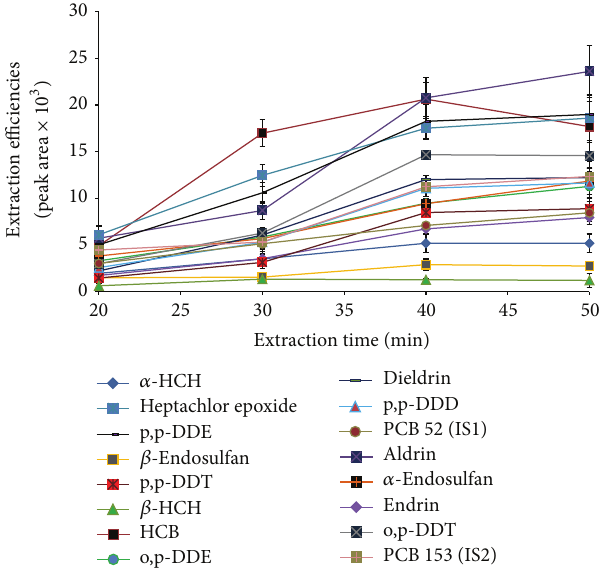
more easily than compounds with higher molecular weights.